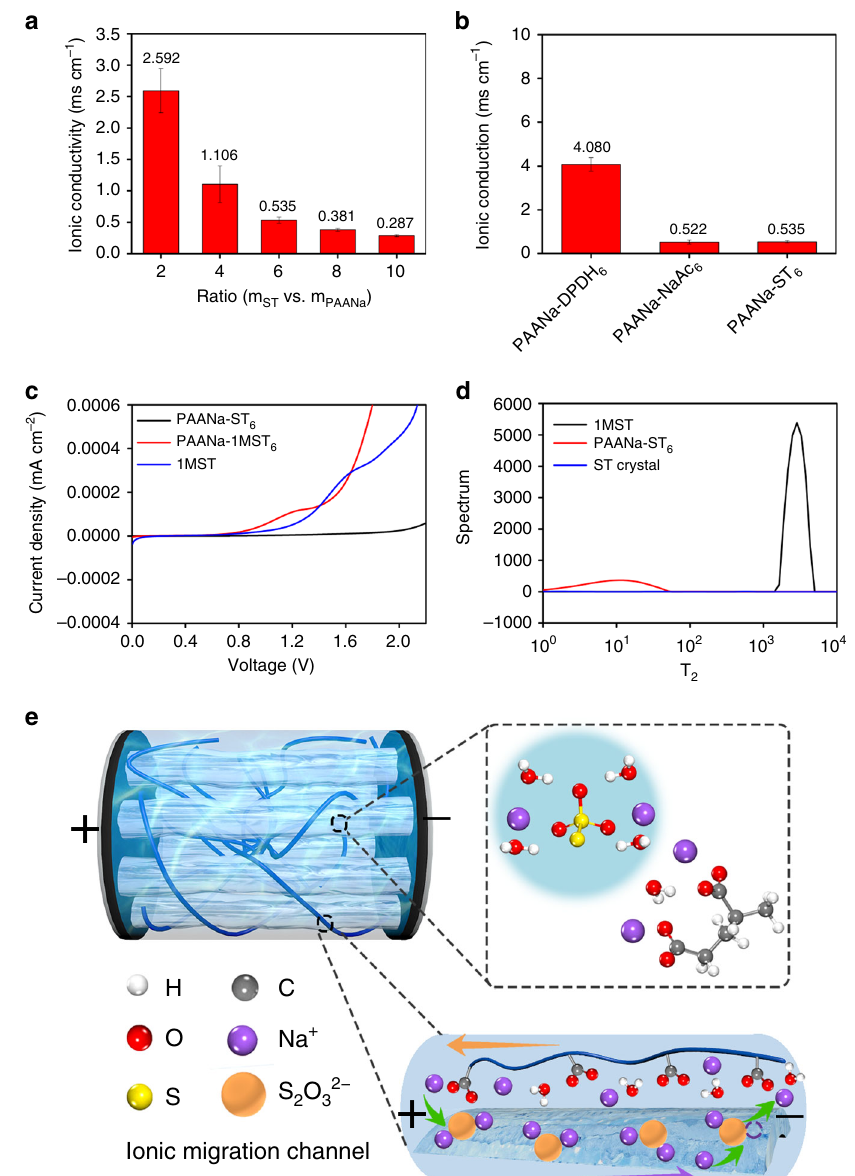
Fig. 3 Water-mediated ionic movement. a Ionic conductivities of the composites with different mass ratios of ST at room temperature. b Ionic conductivities of PAANa-DPDH 6 , PAANa-NaAc 6 and PAANa-ST 6 sample. c Linear sweep voltammetry curves of the traditional liquid electrolyte with 1 M Na 2 S 2 O 3 , the PAANa gel electrolyte with 1 M Na 2 S 2 O 3 , and the PAANa-ST 6 composite electrolyte. d Low- fi eld nuclear magnetic resonance inversion curves of water signals in 1 M ST, ST crystal, and PAANa-ST 6 samples. e Schematic illustration of the ion migration channel built by zwitterionic groups under an external electric fi